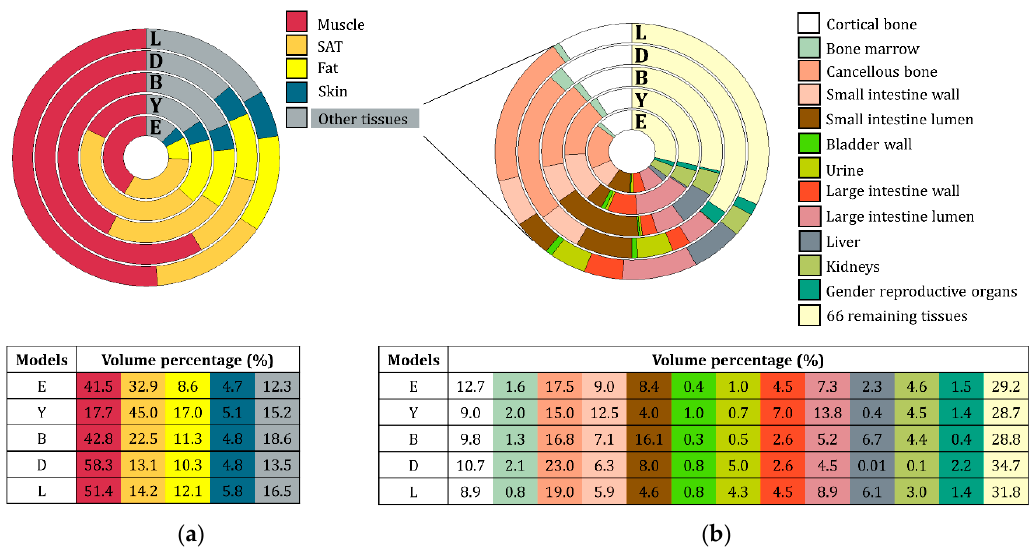
Figure 2. Tissue volume percentage in each virtual model for the body part enclosed by the hyperthermia applicator. The letters presented in the tables and charts correspond to the virtual models: E-Ella; Y-Yoon Sun; B-Billie; D-Duke; L-Louis. ( a ) represents the total tissue volume percentage in each volume, where only the high percentage volume tissues are presented: muscle, fat, SAT (subcutaneous fat), skin, and the remaining other tissues; ( b ) represents the detailed volume percentage of approximately 79 tissues included in the remaining other tissues of ( a ).